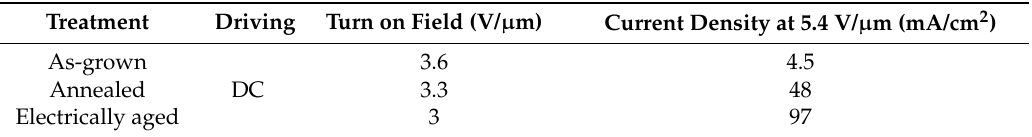
Figure 6. Field emission properties with treatment condition. Table 1. Comparison of electrical properties of carbon nanotube (CNT) emitter with treatment condition. DC–direct current.